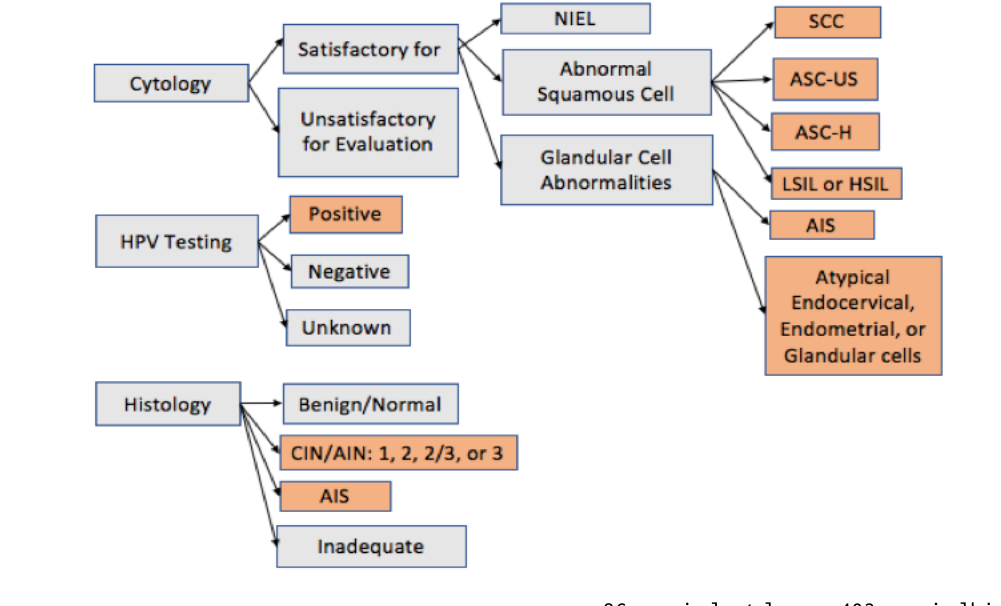
Figure 1. Diagrammatic representation of the classification process for pathology reports (colored indicates abnormal pathology). AIN: anal intraepithelial lesion; AIS: adenocarcinoma in situ; ASC-US: atypical squamous cells of undetermined significance; ASC-H: atypical squamous cells—cannot exclude high-grade squamous intraepithelial lesion; CIN: cervical intraepithelial lesion;HSIL: high-grade squamous intraepithelial lesion; LSIL: low-grade squamous intraepithelial lesion; NIEL: negative for intraepithelial lesion; SCC: squamous cell carcinoma.